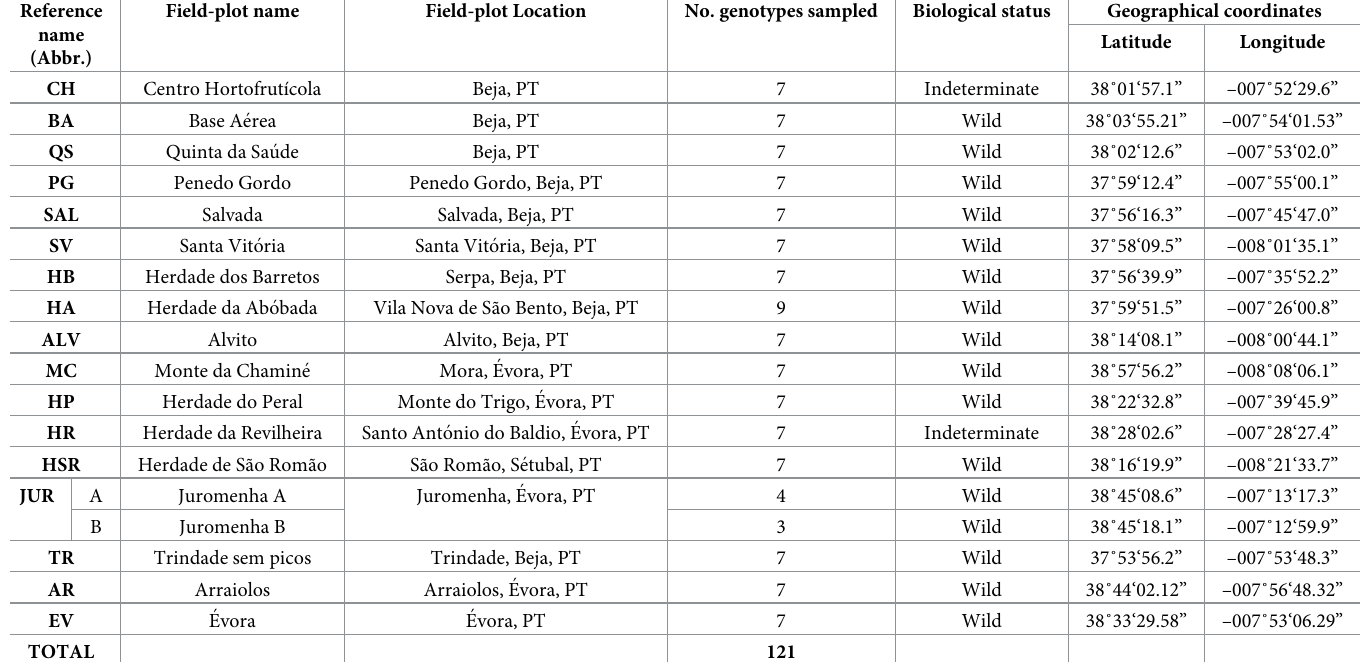
Table 1. Abbreviated reference names, population origin and geographic locations of Cynara cardunculus samples.